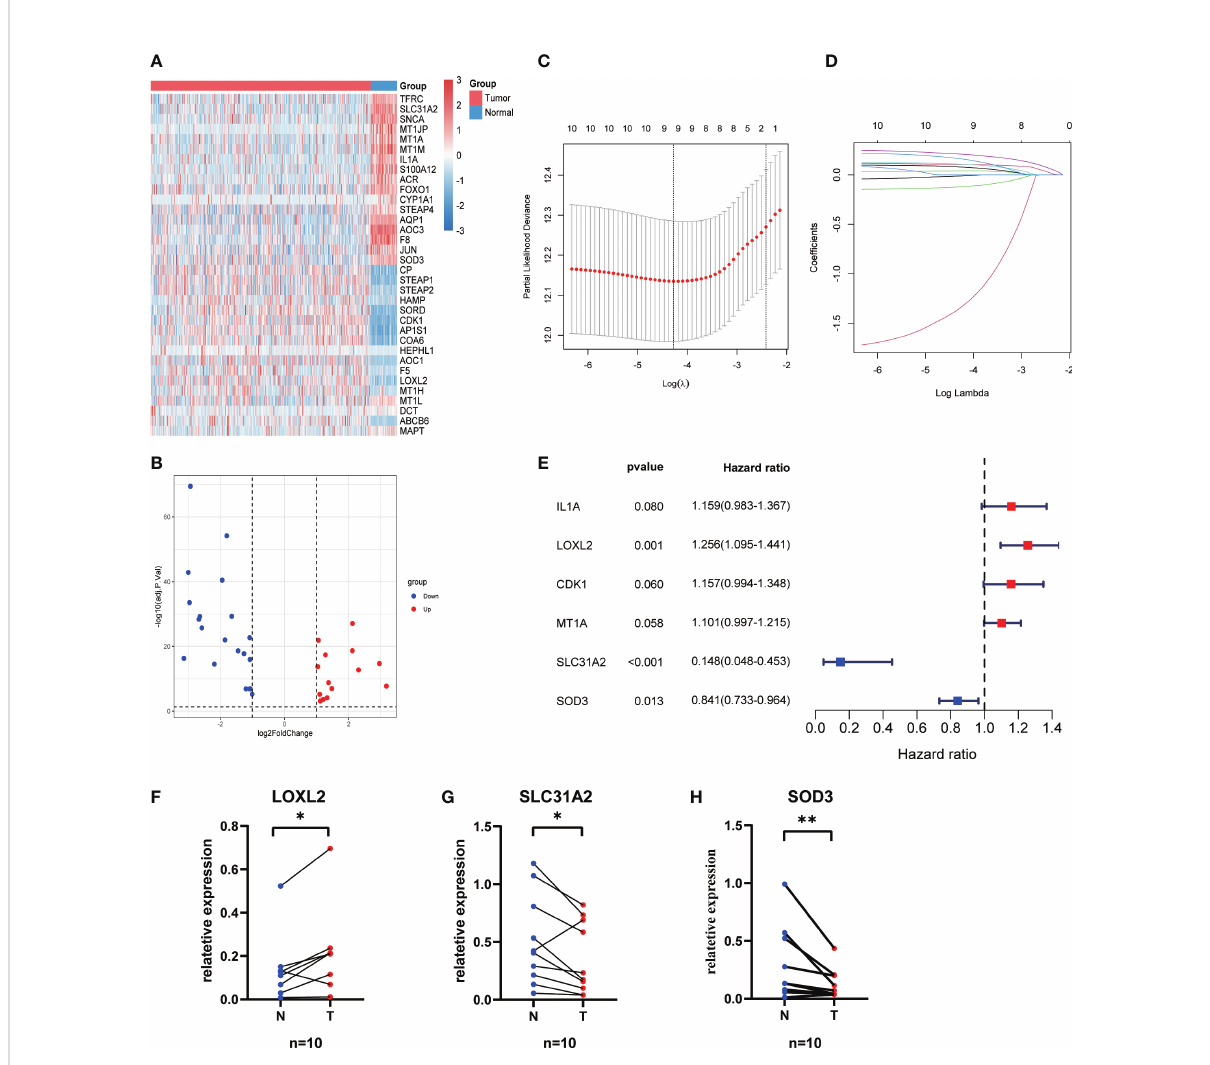
FIGURE 1 Construction of the CMRGS in LUAD. (A) Heatmap showing expression level of differentially expressed CMRGs. (B) Volcano plot exhibiting 20 down-regulated and 13 up-regulated CMRGs. (C, D) Lasso Cox regression analysis of 11 prognosis-related CMRGs. (E) Stepwise multivariate Cox regression analysis of CMRGs. The mRNA expressions of LOXL2 (F) , SLC31A2 (G) and SOD3 (H) in the LUAD and normal lung tissues. P values were shown as: *p < 0.05; **p <